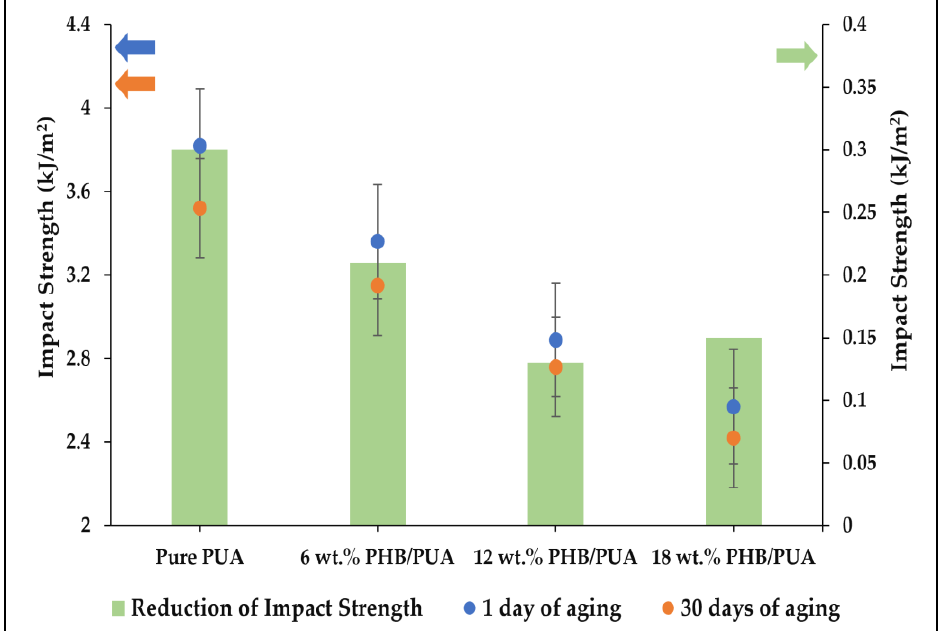
Figure 11. Impact strength value of various 3D-printed PHB/PUA compositions at different aging durations.